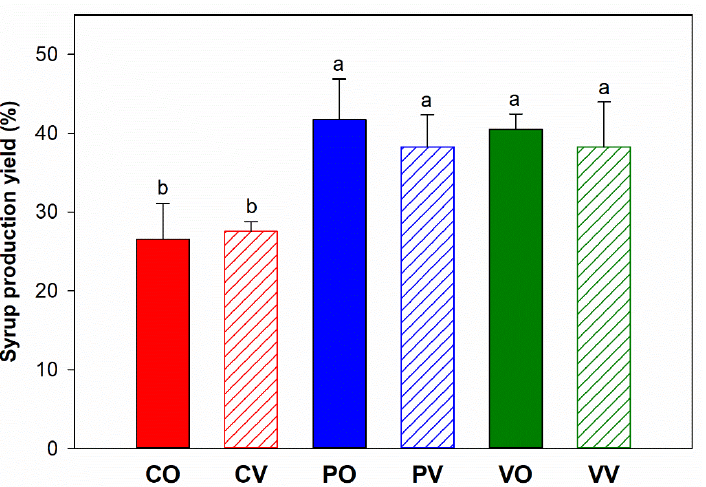
Figure 1. Production yield of date syrups prepared from juice extracted without enzyme (red-color bars: CO, CV), and with the aid of Pectinex (blue-color bars: PO, PV) or Viscozyme (green-color bars: VO, VV) followed by evaporation using open heating (filled bars: CO, PO, VO) or vacuum evaporation (diagonal striped bars: CV, PV, VV). Values are means and standard deviations of triplicate sample ( n = 3). Different letters indicate significant difference between means ( p < 0.05).